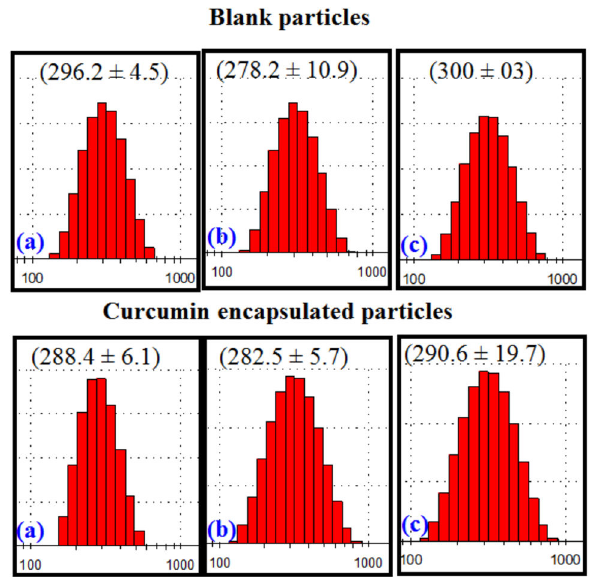
Figure 1. Particle characteristics measured by Malvern zeta sizer fresh (A) after centrifugation (B) and after freeze drying (C). The numbers in parenthesis are average particle size in